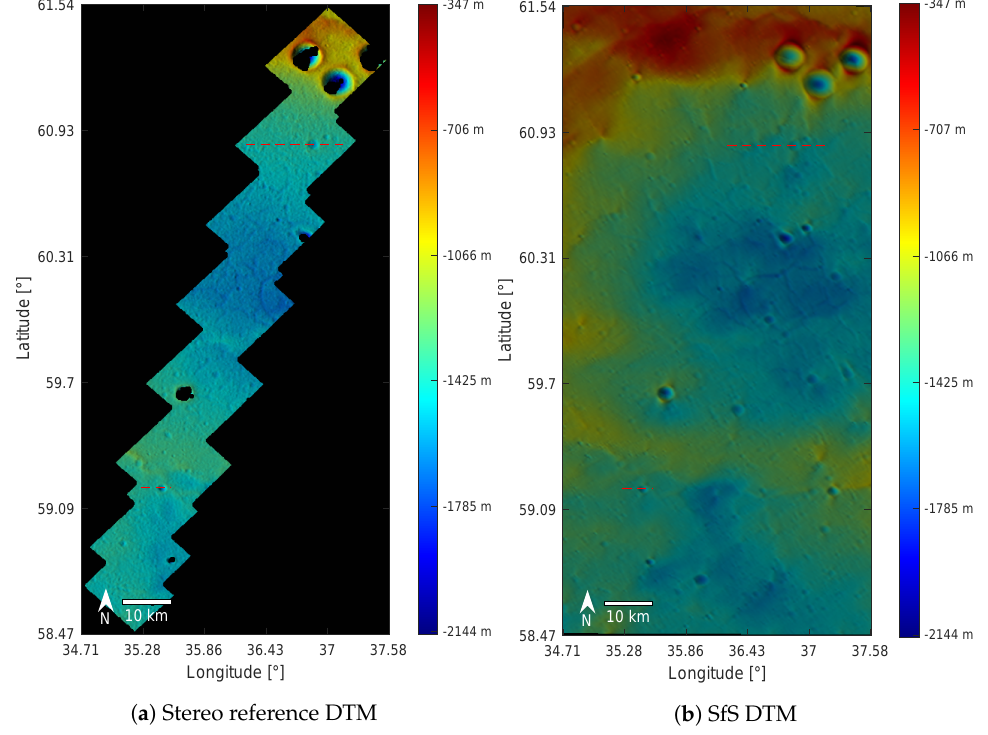
Figure 11. Comparison of the ( a ) reference DTM [29] to the ( b ) SfS DTM. The profiles indicated by the red dashed lines are investigated in Figure 12 from top to bottom. To allow for the comparison, the stereo DTM is scaled to the size of the SfS